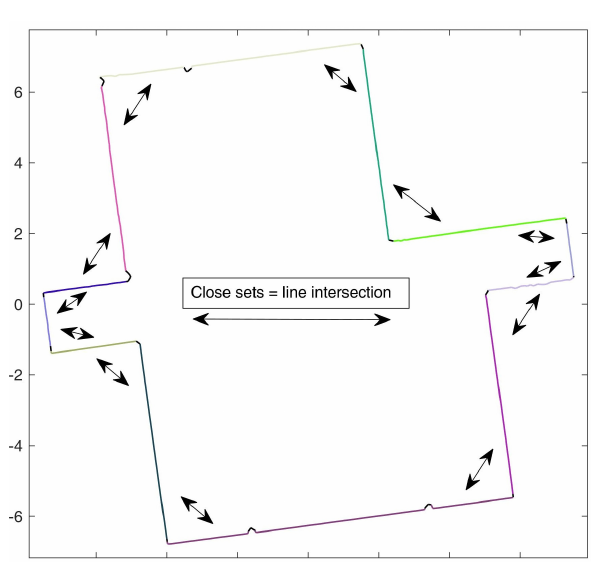
Figure 16: Inlier locations along the border of the polygonal chain. In black the outliers.